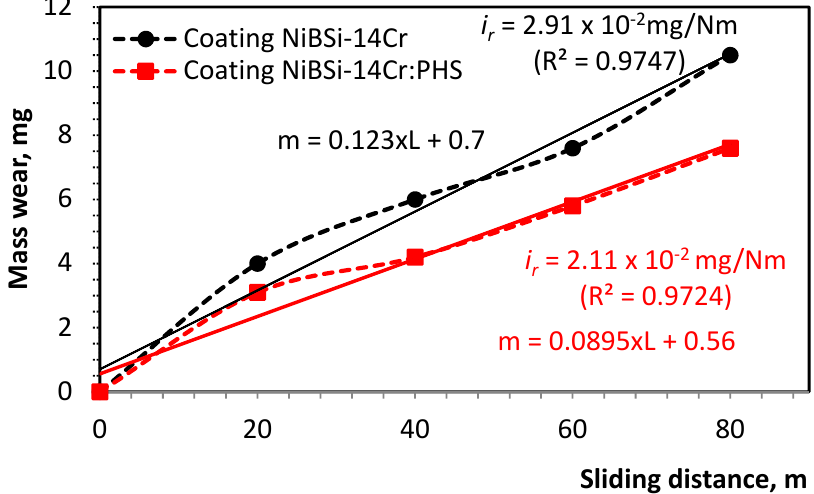
Figure 5. Mass wear vs. sliding distance for NiBSi-14Cr and NiBSi-14Cr: PHS coatings.